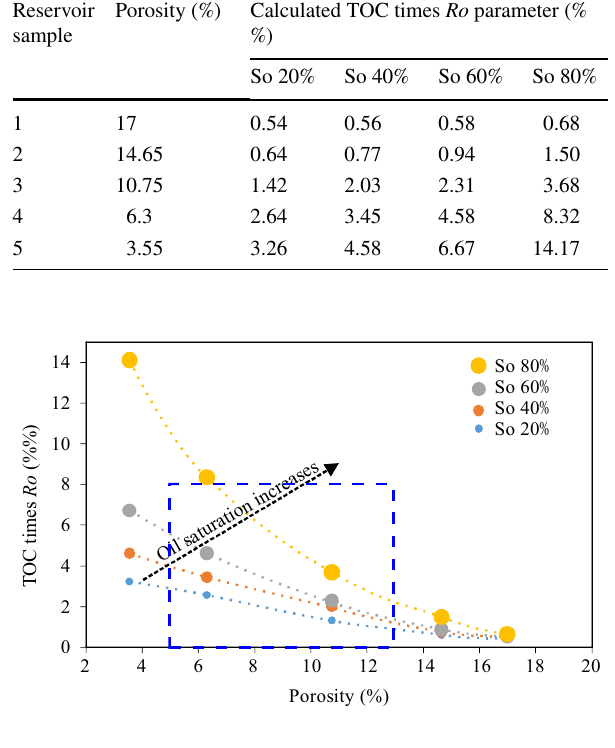
Fig. 2 Tight oil source–reservoir chart. The blue dashed box area is used in Fig.